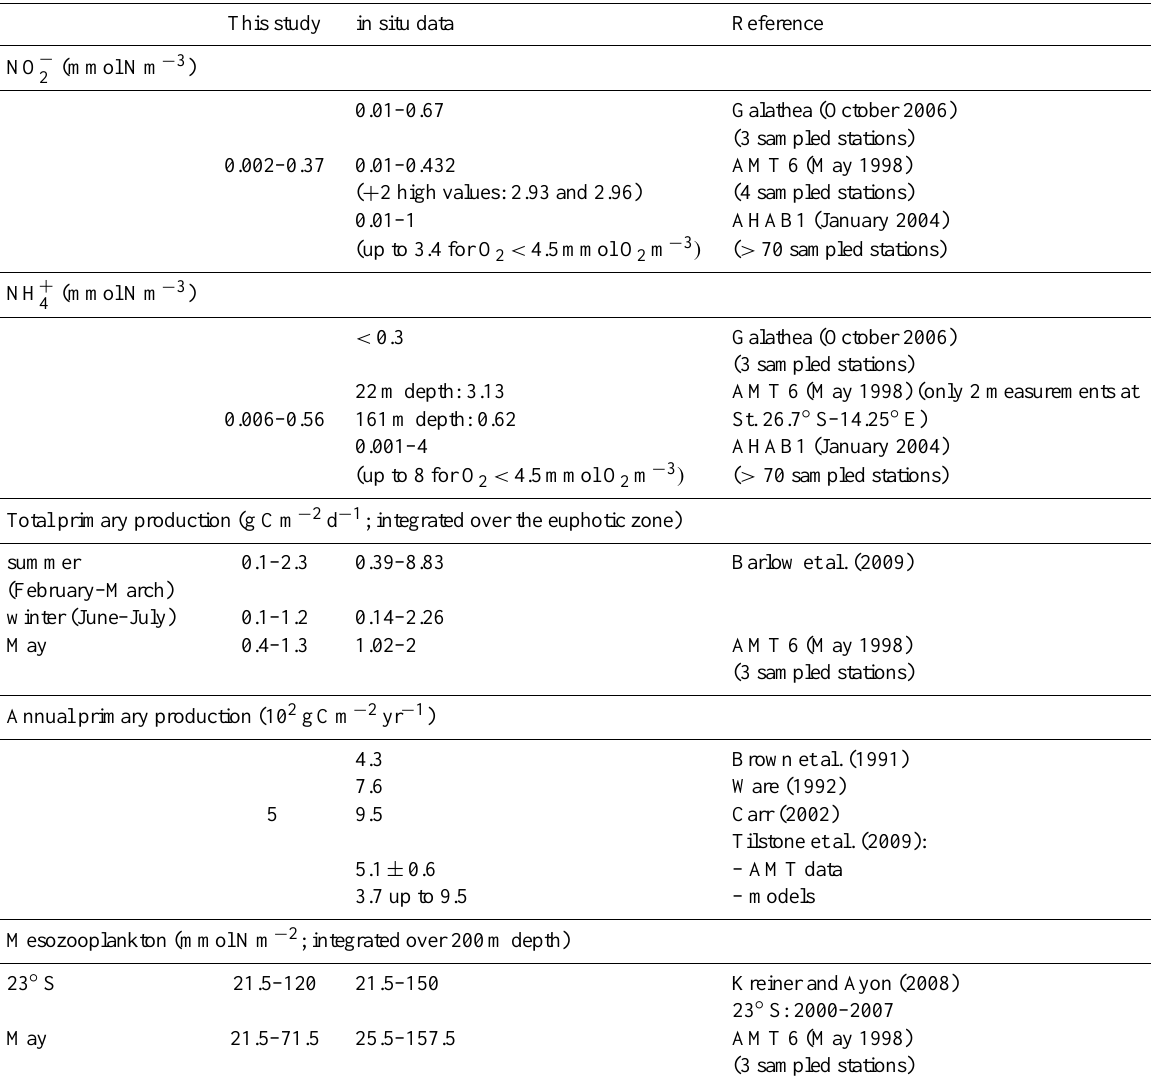
Table 4. Comparison between simulated and in situ data in the modeled domain for nitrite and ammonium concentrations (mmolNm − 3 ), total primary production (gCm − 2 d − 1 ) integrated over the euphotic zone, annual primary production (10 2 gCm − 2 yr − 1 ), and mesozoo- plankton (mmolNm − 2 ) integrated over 200m